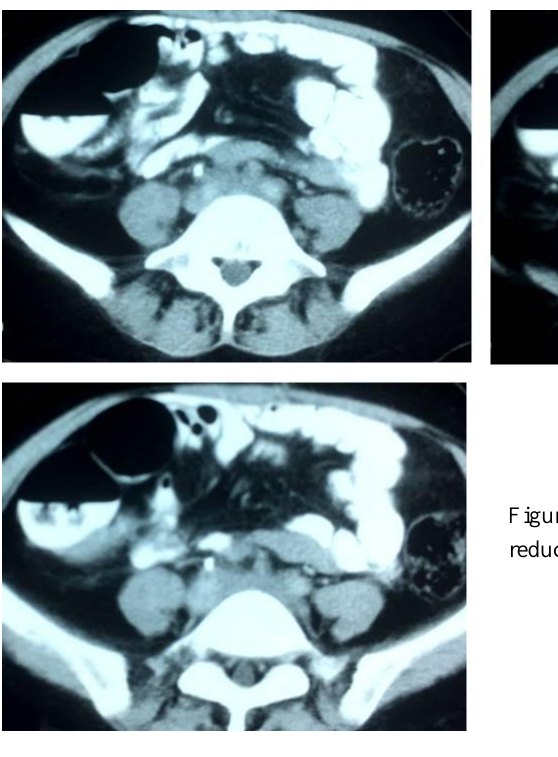
Figure 3: Post treatment CT showing marked reduction in soft tissue